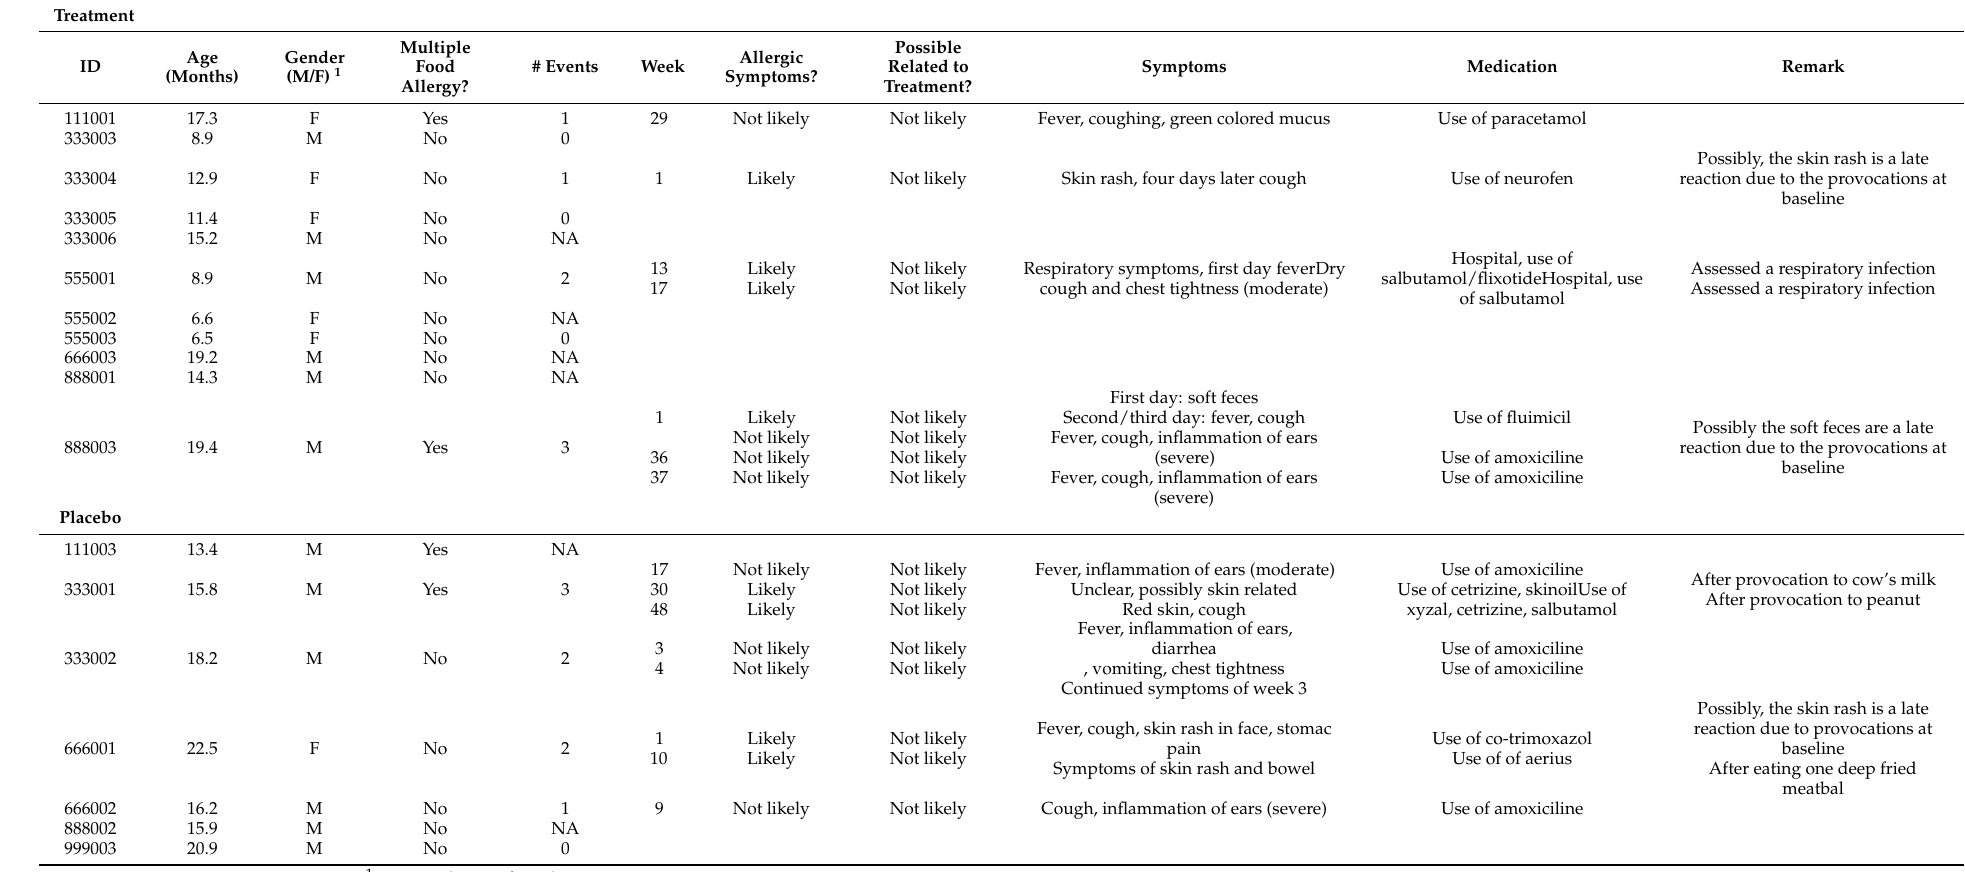
Table 5. Adverse events during the use of the treatment or control